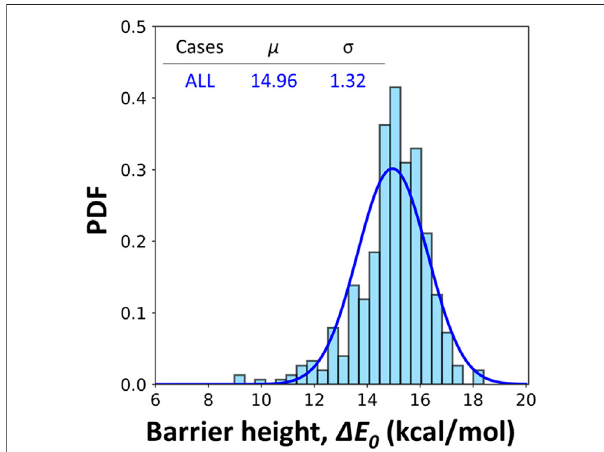
FIGURE 6 | The impact of local textural arrangements on the barrier heightsofhydrogen abstractionreactions byaHradical.Amodelsystemwith two coronene molecules and one naphthalene is considered. The blue, black and orange lines refer to the results of a “ outward ” , a “ perfect parallel ” and an “ inward ” con fi guration, respectively. The rotation angle for both “ outward ” and “ inward ” cases is 15 degree. “ C-H site ” highlights the abstracted hydrogen atoms from model systems. Note that the results are extracted using the frozen